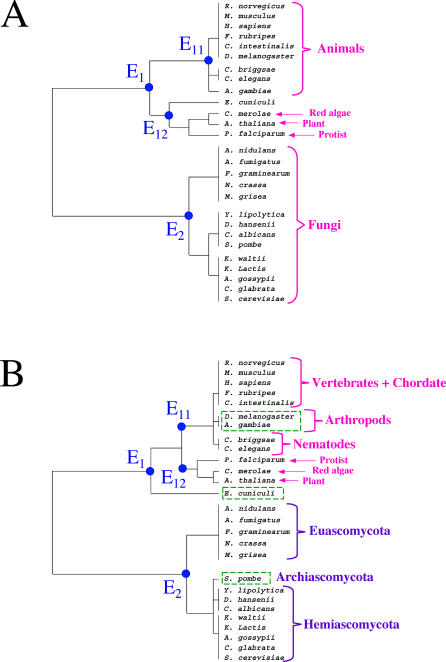
Eukaryal BranchThe eukaryal branch is represented in more detail with (A) eukarya subtree (see Materials and Methods) based on the restriction of the Jaccard scores matrix to the lines corresponding to eukaryal species, and (B) eukarya only subtree based on the restriction of the Jaccard scores matrix to the lines and the columns corresponding to eukaryal species.